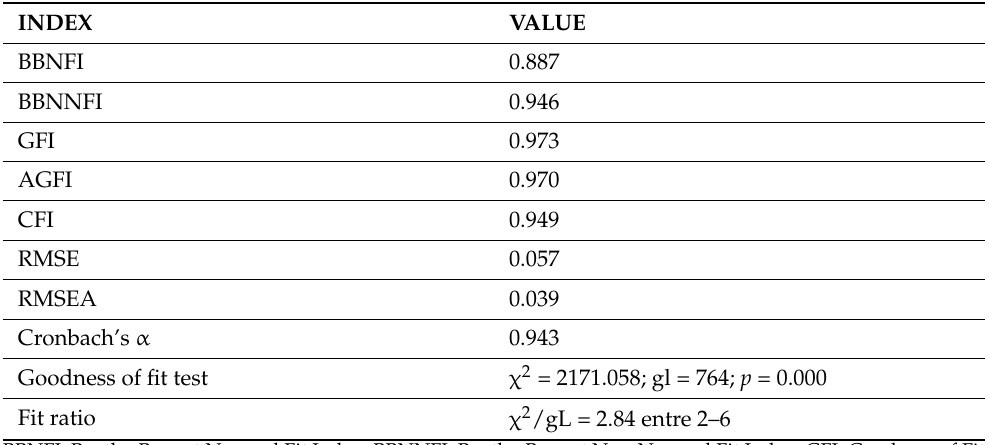
Table 7. Goodness of fit indices of the Confirmatory